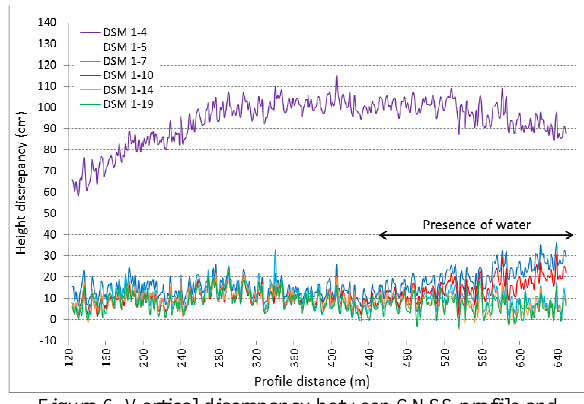
Figure 6. Vertical discrepancy between GNSS profile and DSMs extracted profiles Vertical discrepancy histograms of DSM 1-7 and DSM 1-19 show that the majority of elevation discrepancies are between 5 cm and 15 cm (Figure 7). The most common discrepancy is 10 cm for the flight 1-7 and 7 cm for the flight 1-19.